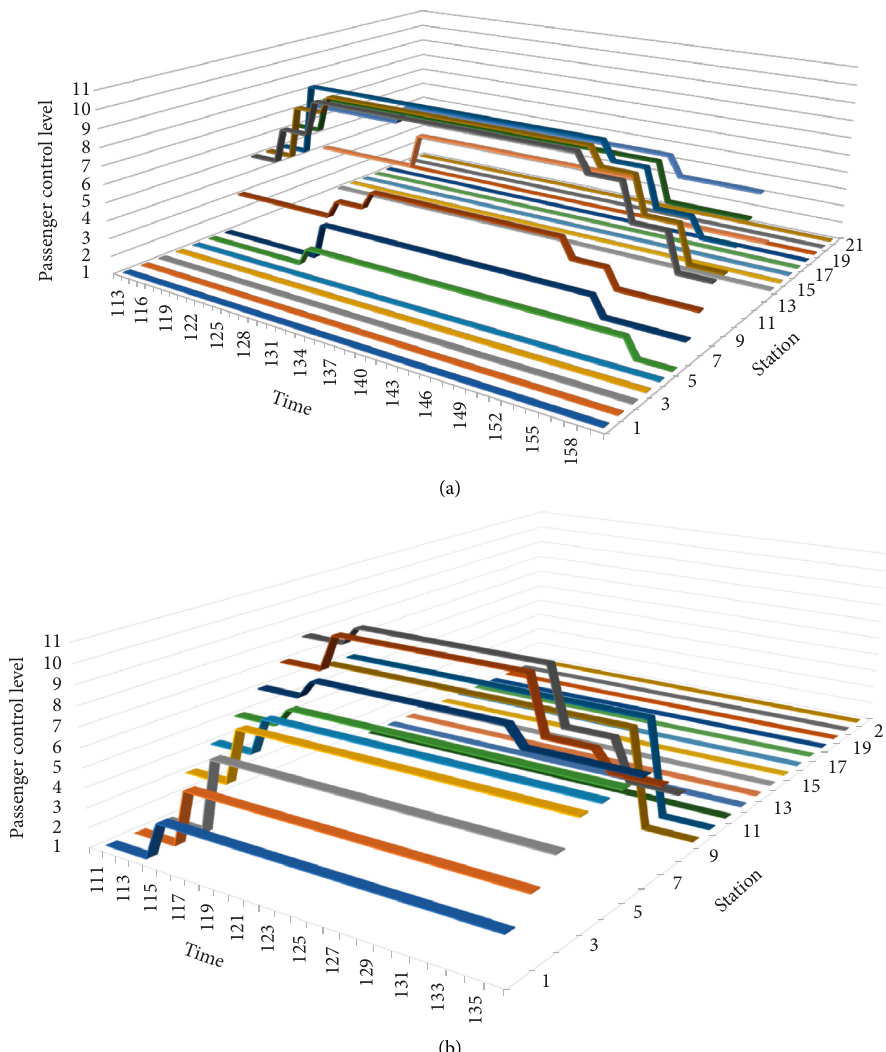
Figure 13: Passenger control strategy of each line. (a) Passenger control strategy of Line 1 and (b) passenger control strategy of Line